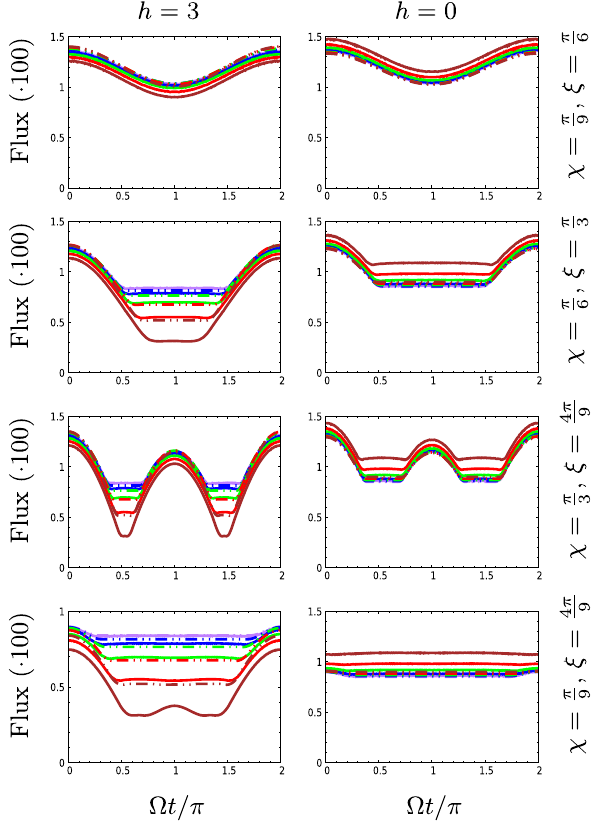
Fig. 16 Same parameters and color references as in Fig.15 but for RN-like metric, with q ∗ = − ( 0 . 75 M ) 2